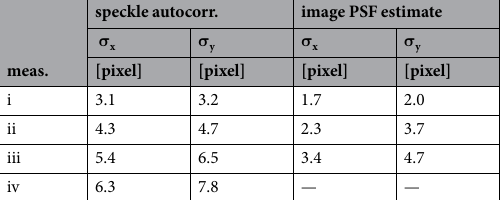
Table 1. Summary of the resulting root-mean-square widths of the speckle autocorrelation peak and image point spread function (PSF) estimate for the four measurements in Fig. 4A,B. For the measurement (iv) the PSF values could not be